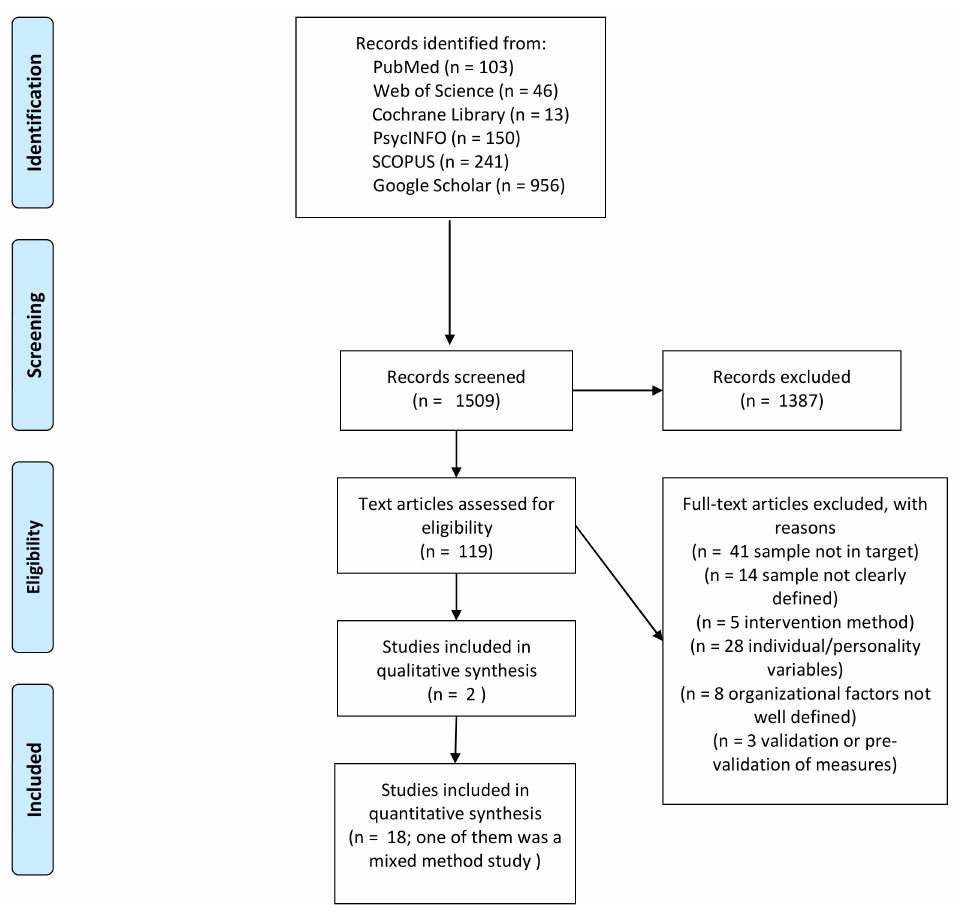
Figure 1. Article-selection algorithm (PRISMA)